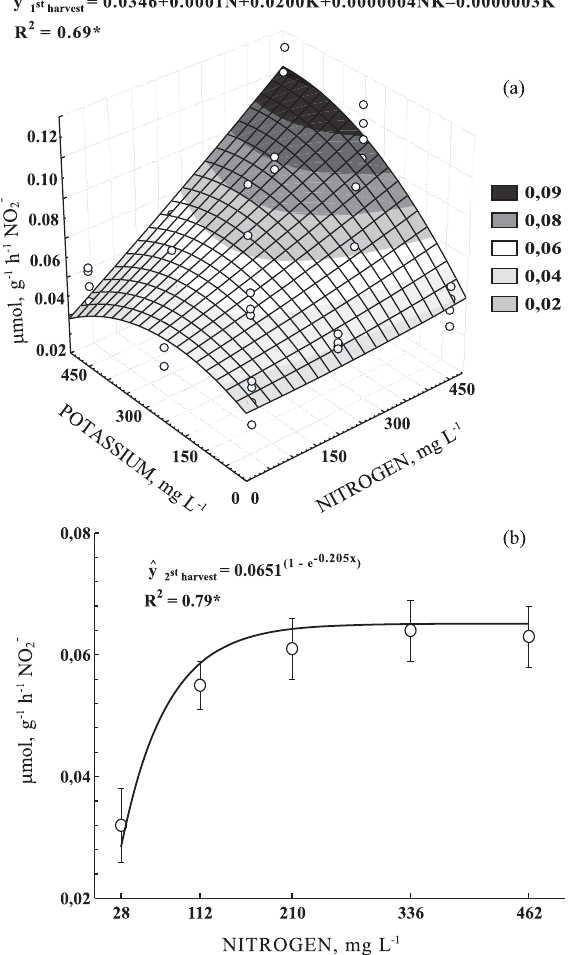
Figure 2. Nitrate reductase activity taken on the newly expanded lamina leaf (NL) of ‘Mombaça’ grass, in the first (a) and second (b) growth, as related to N and K or N